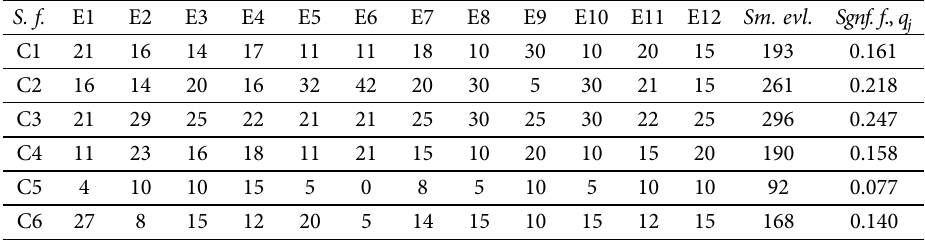
Table 15. The significance of factors in the group of a financial environment regarding the commercial potential of technologies S.